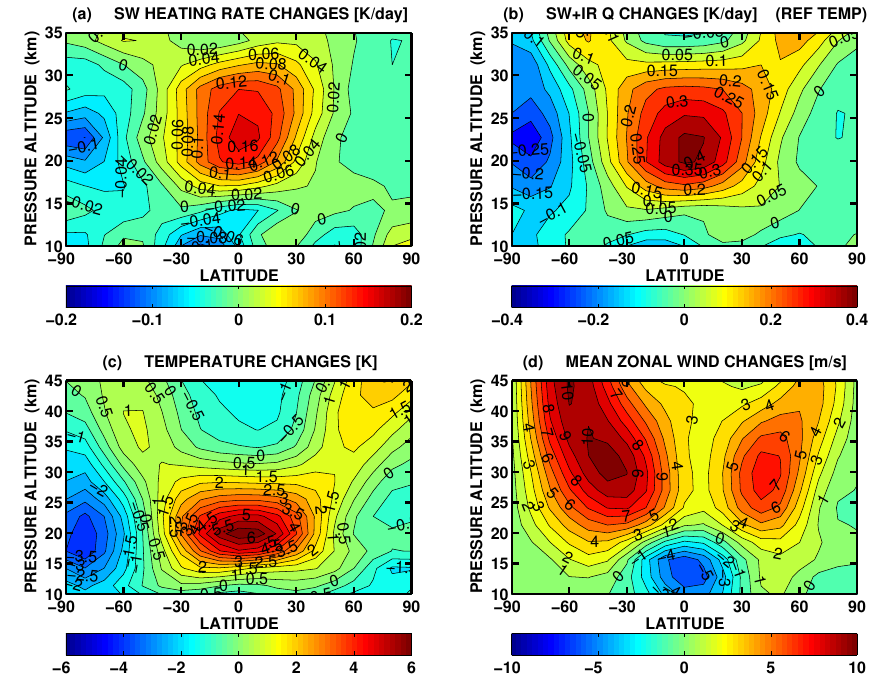
Figure 4. ULAQ-CCM-calculated mean zonal anomalies due to the Pinatubo aerosols (VE-REF), during September ´ October ´ November 1991: ( a ) solar heating rates (K/day); ( b ) total heating rates, i.e. , solar + longwave (“instantaneous” value with fixed REF temperatures) (K/day); ( c ) temperatures (K); ( d ) zonal winds